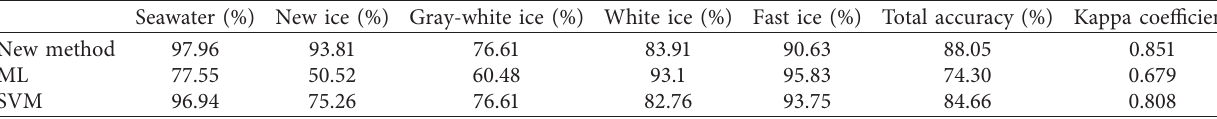
Table 3: Classification accuracy statistics compared with ML and